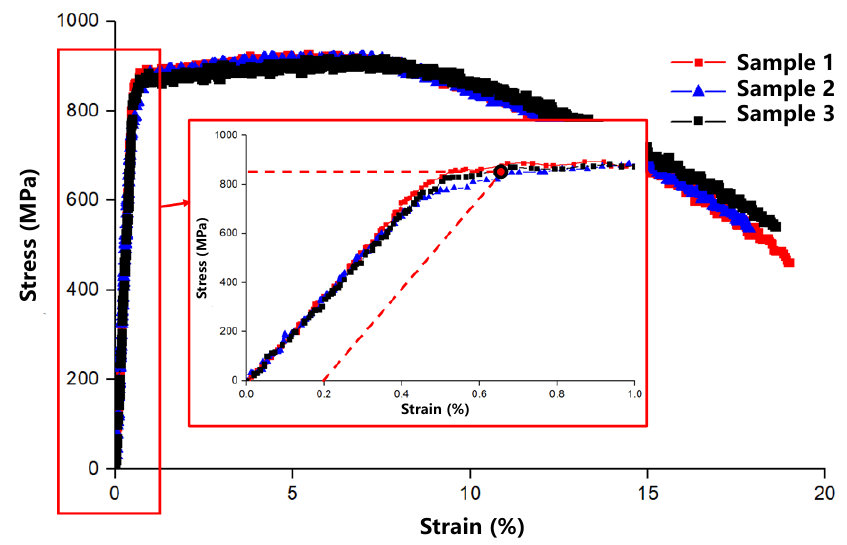
Figure 4. The stress-strain relationship of 13Cr110 (25 °C). Table 1. Static mechanical properties of the 13Cr110, as extracted from the stress-strain curves (25 °C).